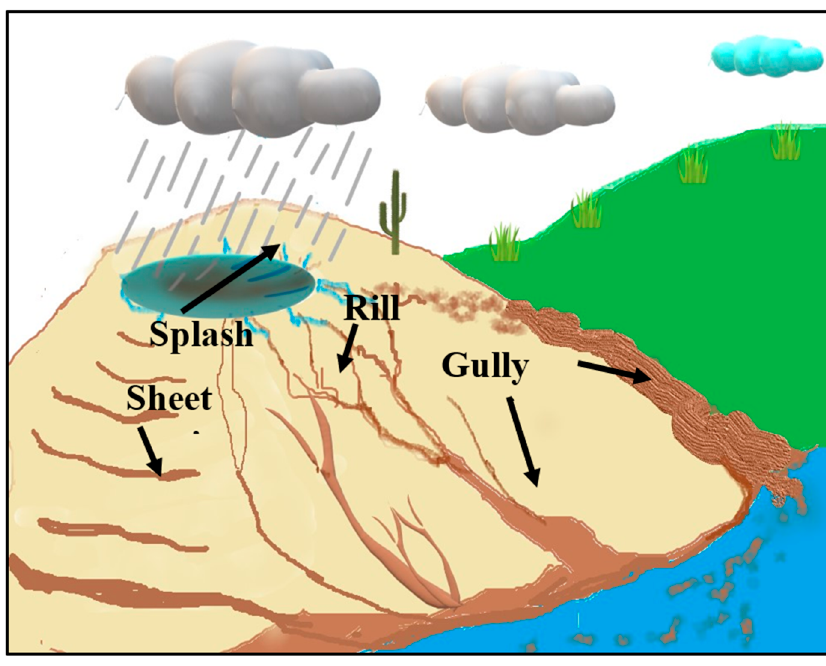
Figure 1. The types of soil erosion by water.